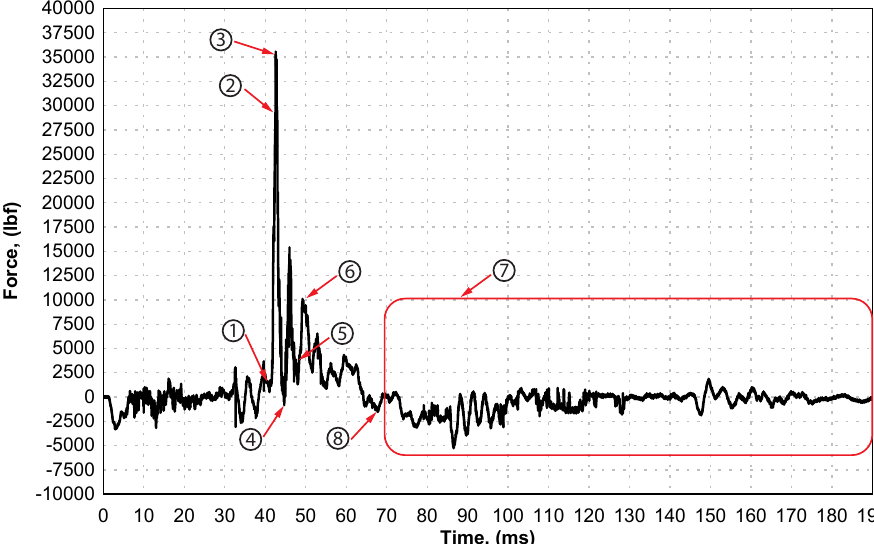
Figure 25. CLT3-5 Damage detection in net impact force